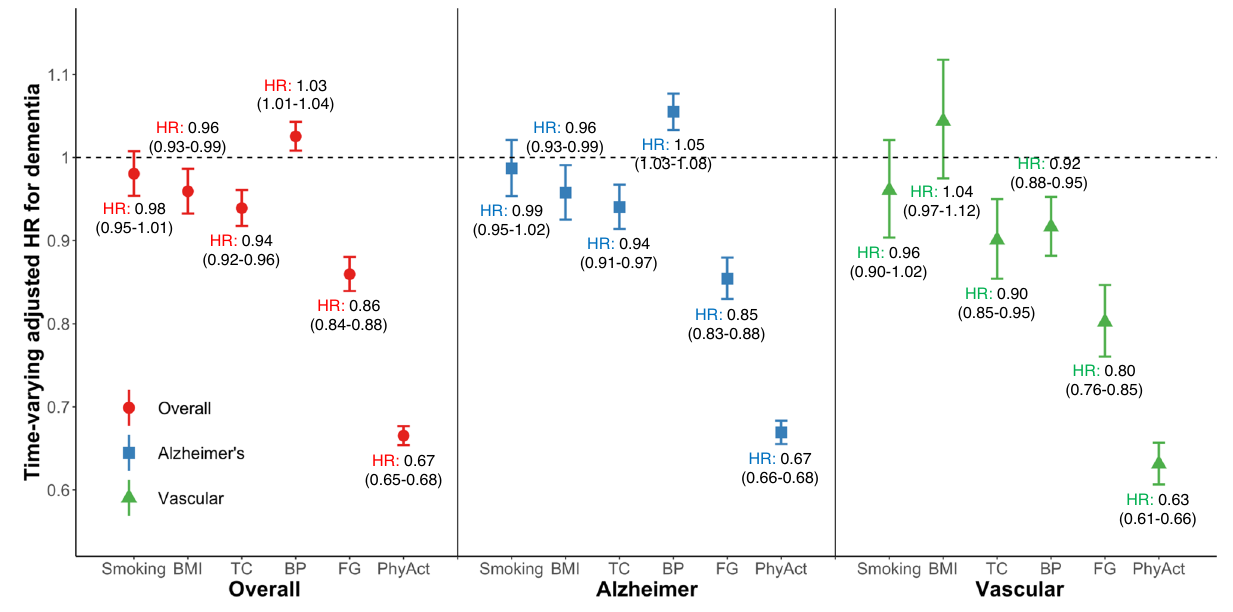
Figure 3. A plot of time-varying HRs for the association of individual components of CVH metrics with the risk of dementia. Stroke censoring was performed in the analysis. The associations between the risks of each type of dementia and individual components of CVH metrics were investigated separately. Each level of individual CVH metrics was included as a time-varying variable, and the poor levels of each component was used as a reference value compared to the intermediate and optimal levels combined. All multivariable time- varying Cox regression models were adjusted for age, sex, economic status, living area, comorbidities (AF, HF, MI, coronary heart disease, PAD, anemia, CKD, hyperthyroidism, hypothyroidism, osteoporosis, sleep apnea, COPD, chronic liver disease, and cancer), medications (oral anticoagulants, antiplatelet agents), depressive mood, lower extremity function, and cognitive function at baseline. Each component of CVH metrics, as time- varying variables, was mutually adjusted for each other in addition to all other covariates. Each type of dots with interval bars indicates time-varying multivariable-adjusted HRs and 95% CIs (exact values of HR with 95% CI on each type of dementia are displayed above or below each interval bar). Abbreviations: AF atrial fibrillation; BMI body mass index, BP blood pressure, CI confidence interval, CKD chronic kidney disease, COPD chronic obstructive pulmonary disease, CVH cardiovascular health, FG fasting glucose, HF heart failure, HR hazard ratio, MI myocardial infarction, PhyAct physical activity, PAD peripheral artery disease, TC total